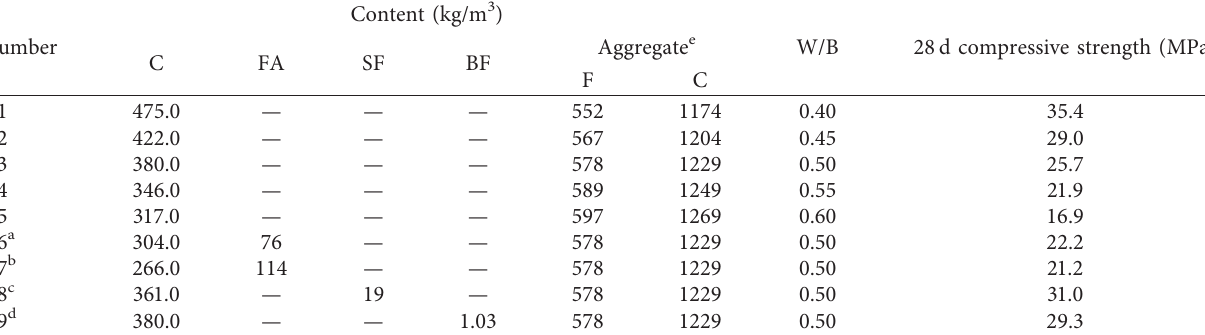
Table 3: Concrete mixture proportions f .